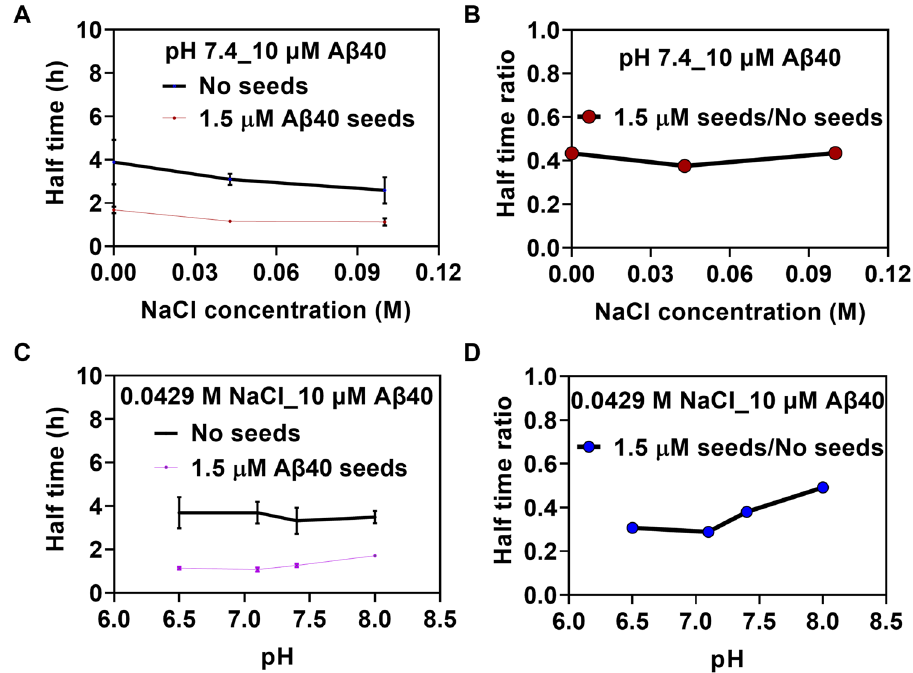
Fig. 6 Seeding experiments of A β 40 under the varied experimental conditions. The half time (t_ 1/2 ) values of 10 μ M A β 40 kinetics at varied NaCl concentrations ( A ) and pH values ( C ) in the absence and presence of 1.5 μ M A β 40 seeds, shown as mean + SEM. The half time ratios ( B ) and ( D ) were obtained with averaged half times.